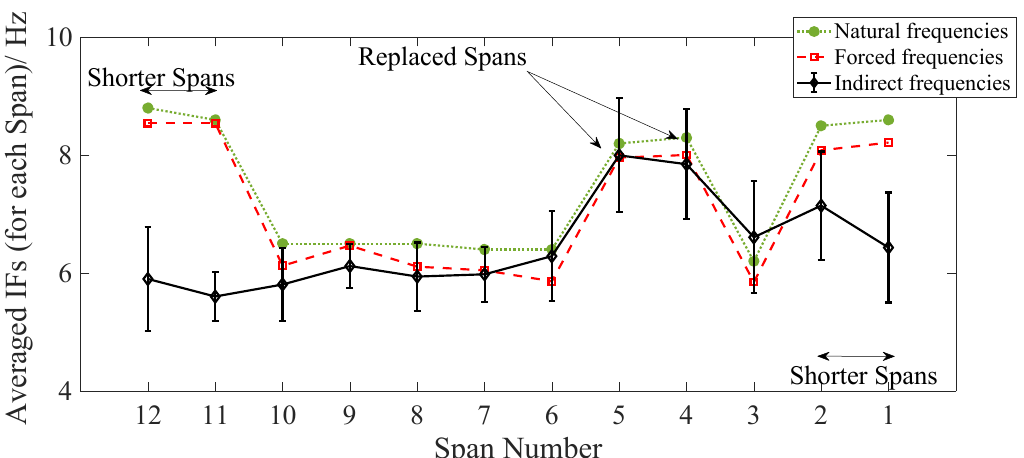
Figure 13. Averaged IFs of each Span (from IMF 6) from the indirect measurements (compared to the direct measurements).